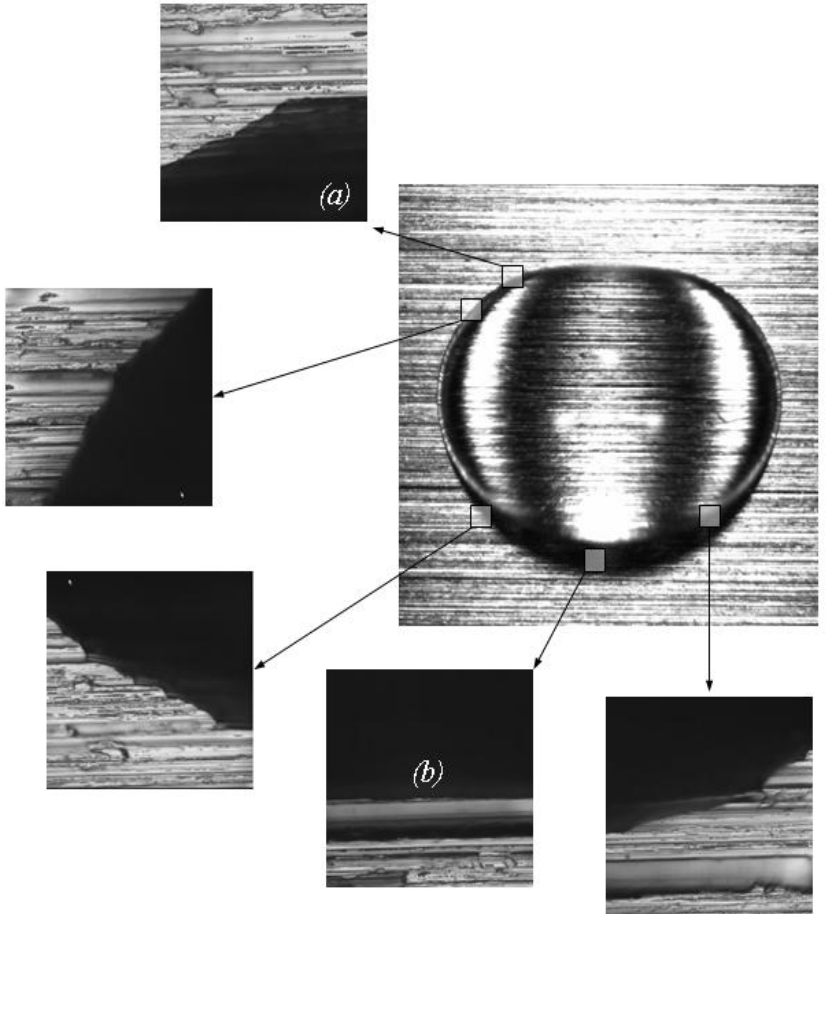
Figure 5. Effect of topographic anisotropy of stainless steel on the water drop boundary at different locations. The measure side length of the droplet image is 5 mm. The measured side length of all the zooms is 160